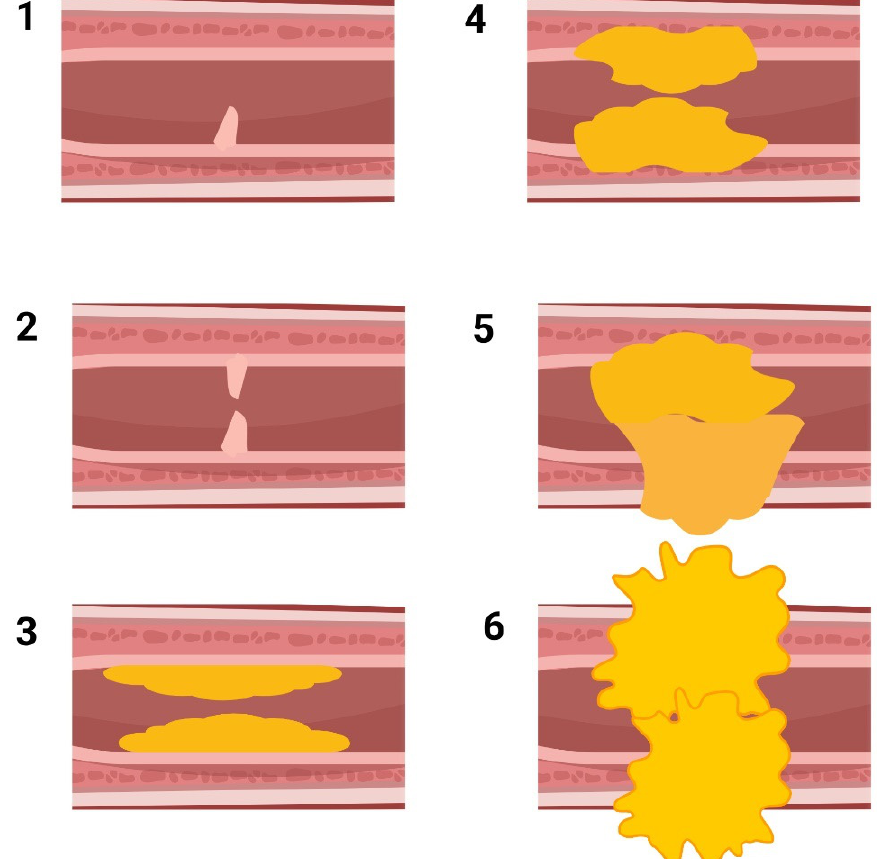
Figure 1. Schematic illustration representing the pathophysiology of urethra stricture. Stage 1 shows mucosal fold. In this stage, minor defects in the metaplastic tissue cause urinary extravasation that triggers the establishment of a fibrotic reaction. Increased deposition of ECM components results in the progression to further stages of US. Stage 2, shows Iris constriction. In stage 3, the fibrotic reaction has penetrated the spongiosum and caused a minimal fibrosis in the spongy tissue. Stage 4 shows full-thickness spongiofibrosis. In stage 5, fibrosis has penetrated the tissues outside the corpus spongiosum. In stage 6, a complex US has formed that is usually accompanied by a